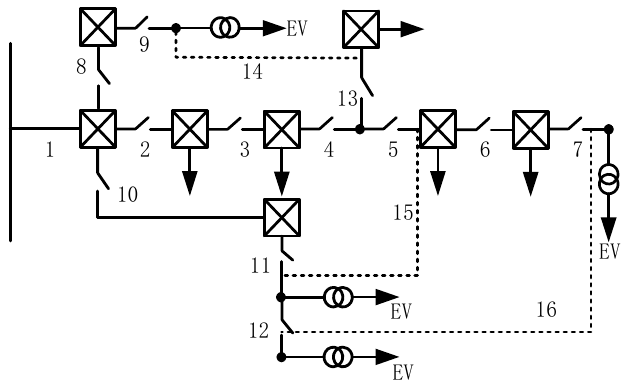
Figure 10. Structure diagram under a switch station.